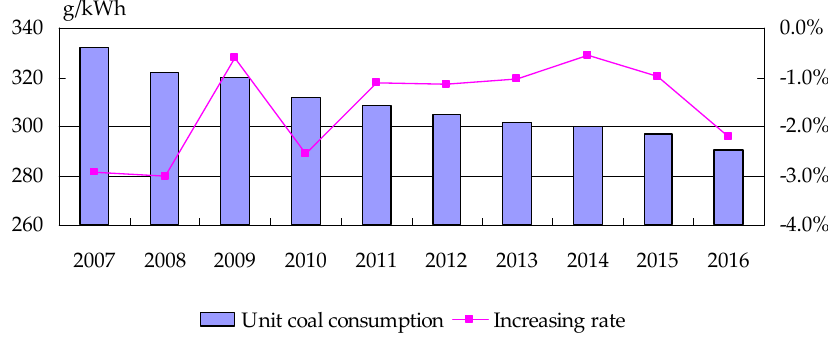
Figure 5. The unit coal consumption changes of thermal power from 2007 to 2016.